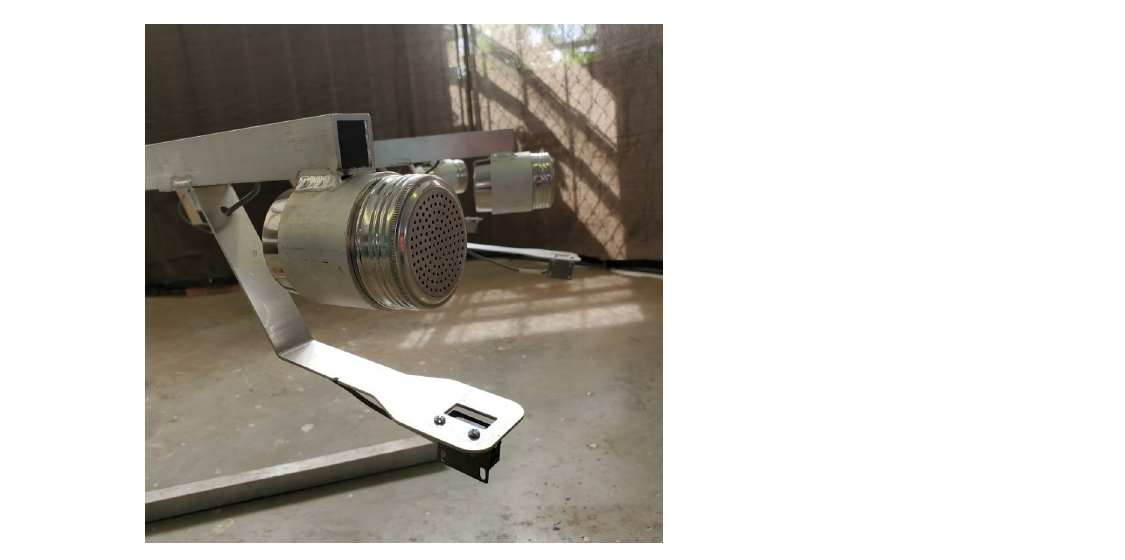
Fig 2. Close up of port on scent